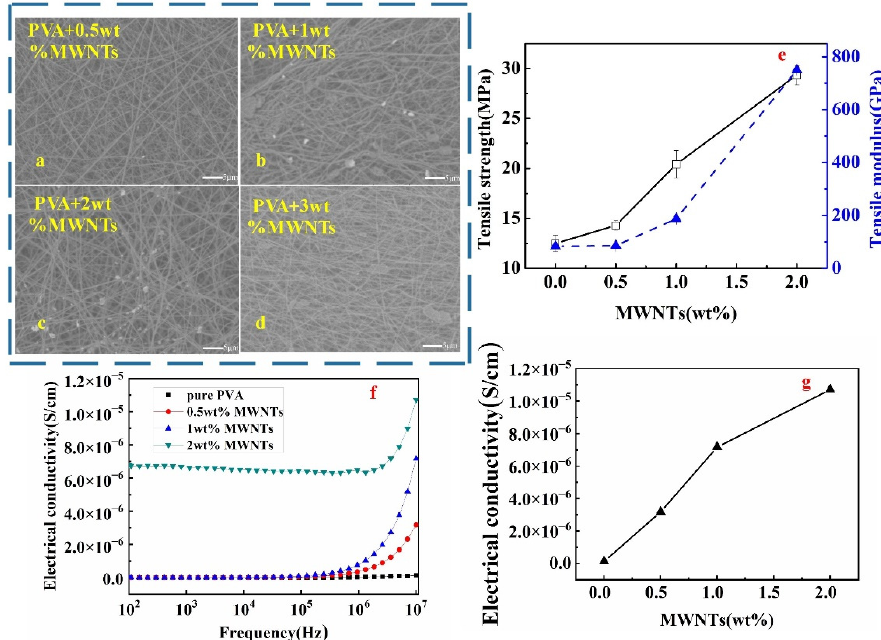
Figure 3. The performance of PVA/ MWNT membrane in different mass fractions: ( a – d ) the surface of the membrane by SEM; ( e ) the tensile strength and modulus of membrane; ( f , g ) the conductive property of membrane in different frequencies.